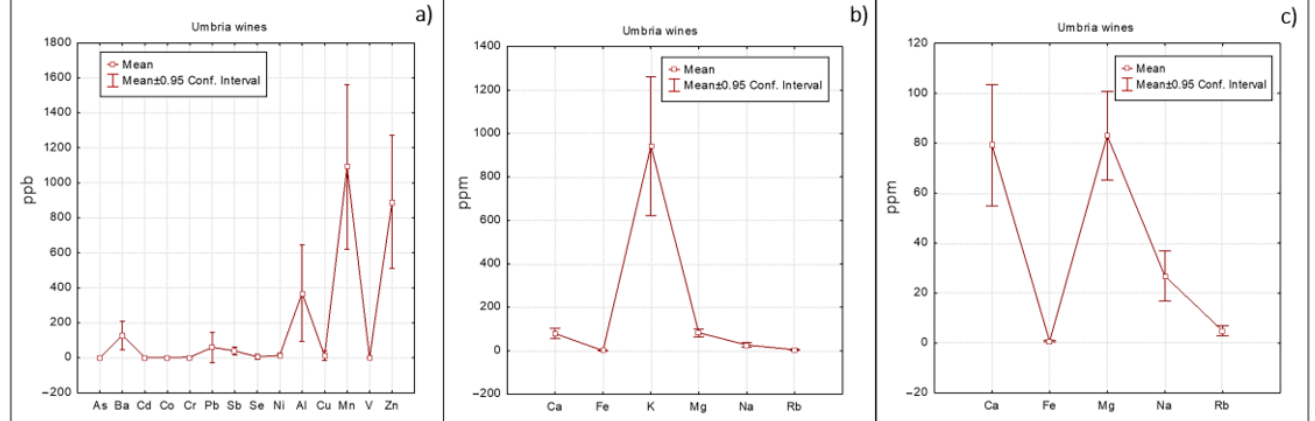
Figure 4. Elements trend concentration for Umbria wines: ( a ) minor elements, ( b ) major elements and ( c ) major elements excluding K.